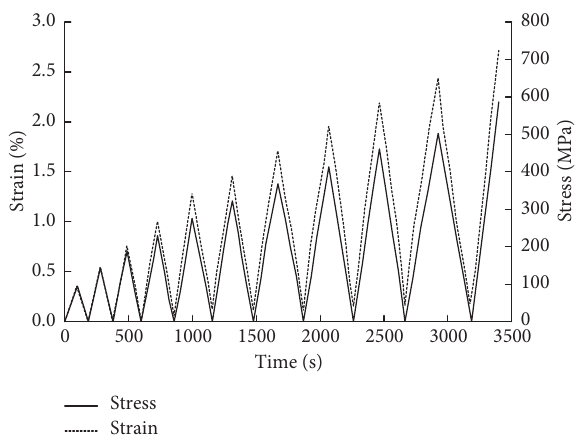
Figure 12: Curve of stress-strain of the composite specimen.